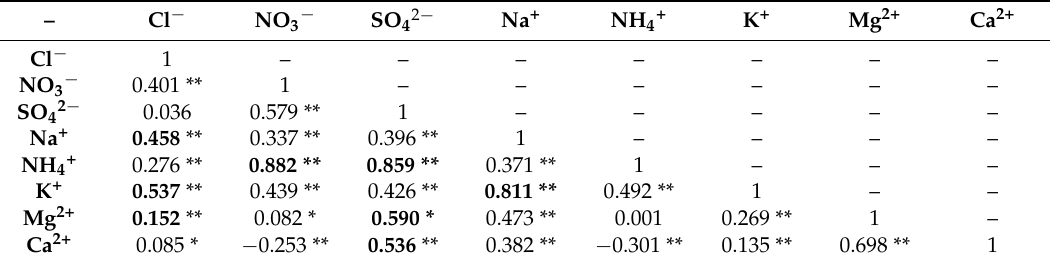
Table 3. Pearson correlation of the water-soluble ions in PM 2.5 in the spring.